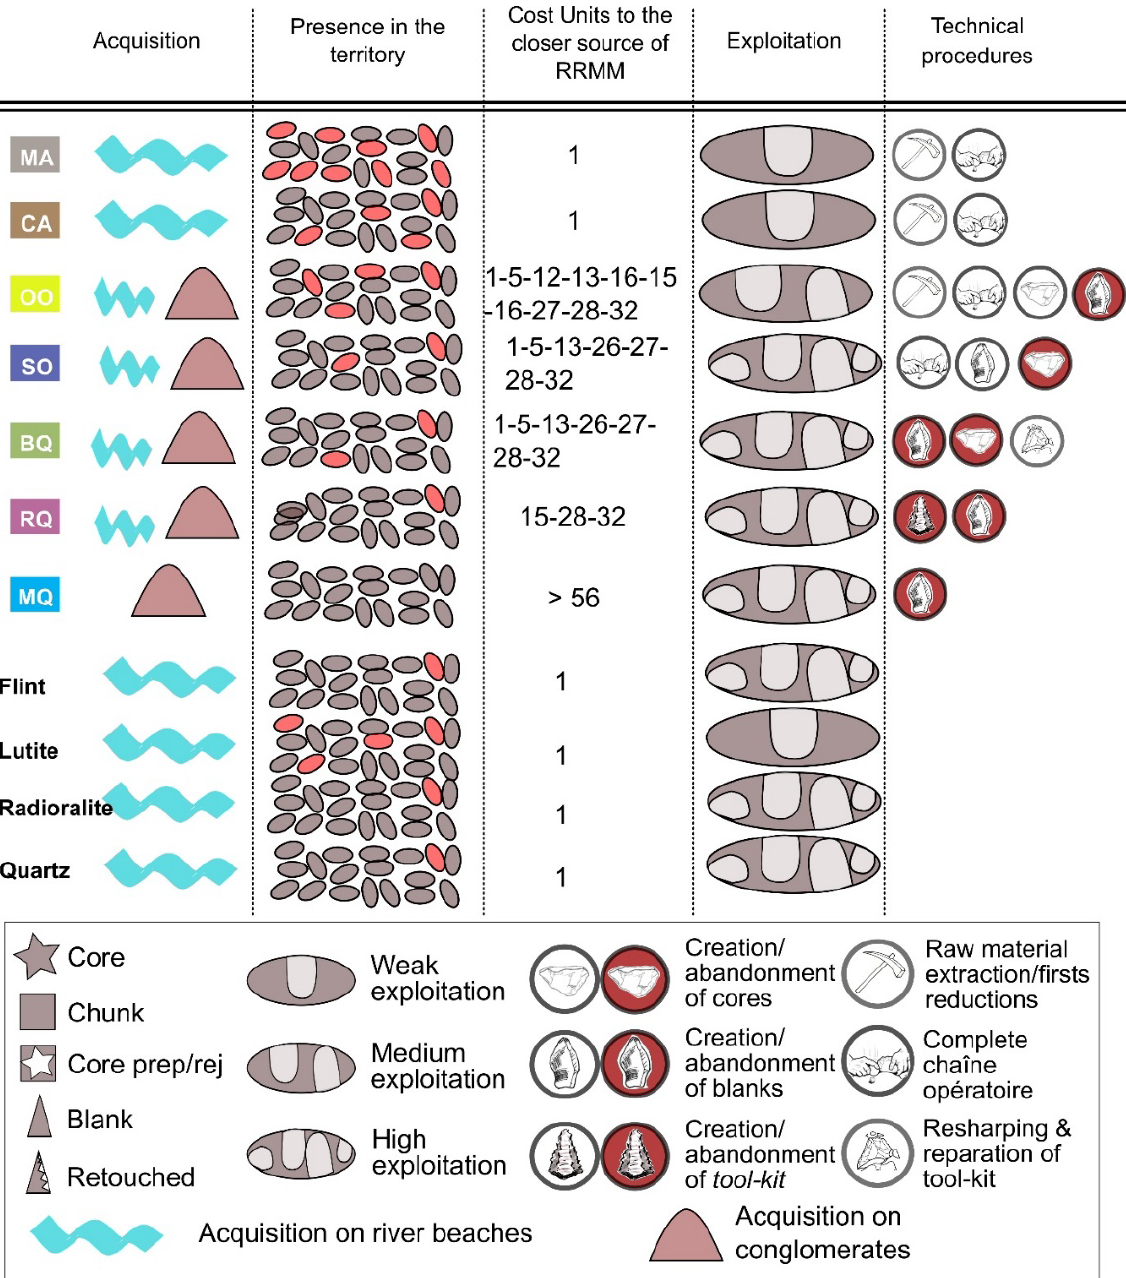
Figure 11. Systematic management strategies followed by human populations who inhabited El Esquilleu in the timeframe of Layer XXII-R, grouped by raw material and petrogenetic